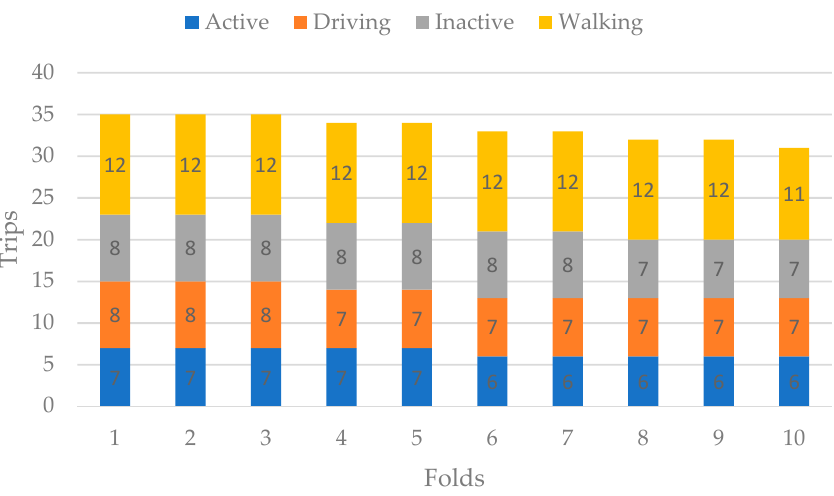
Figure 5. Distribution of trips among ten folds.